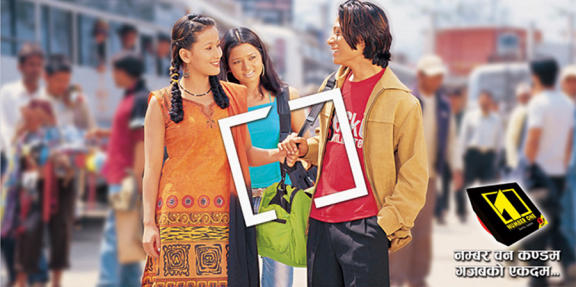
Advertisement for “Number One” Condoms Marketed in Nepal by Population Services InternationalIn April 2003, Nepal launched Number One condoms with support from USAID. In January 2004, Population Services International, a non-profit organization that uses social marketing to encourage condom use, launched Number One single-pack condoms for high-risk target groups.